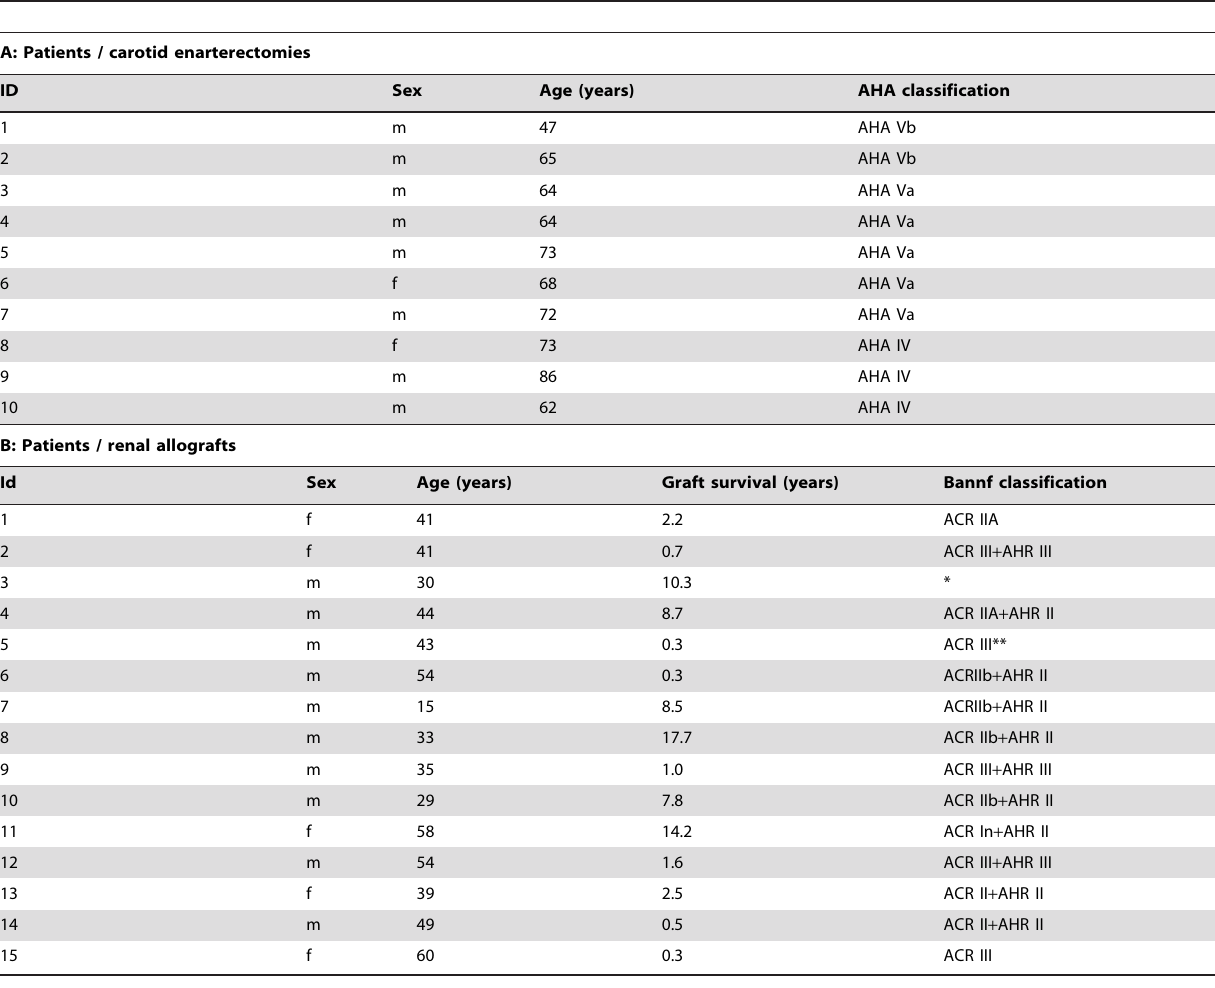
Table 1. Demographical and histopathological characteristics of the patients and nephrectomy specimens.